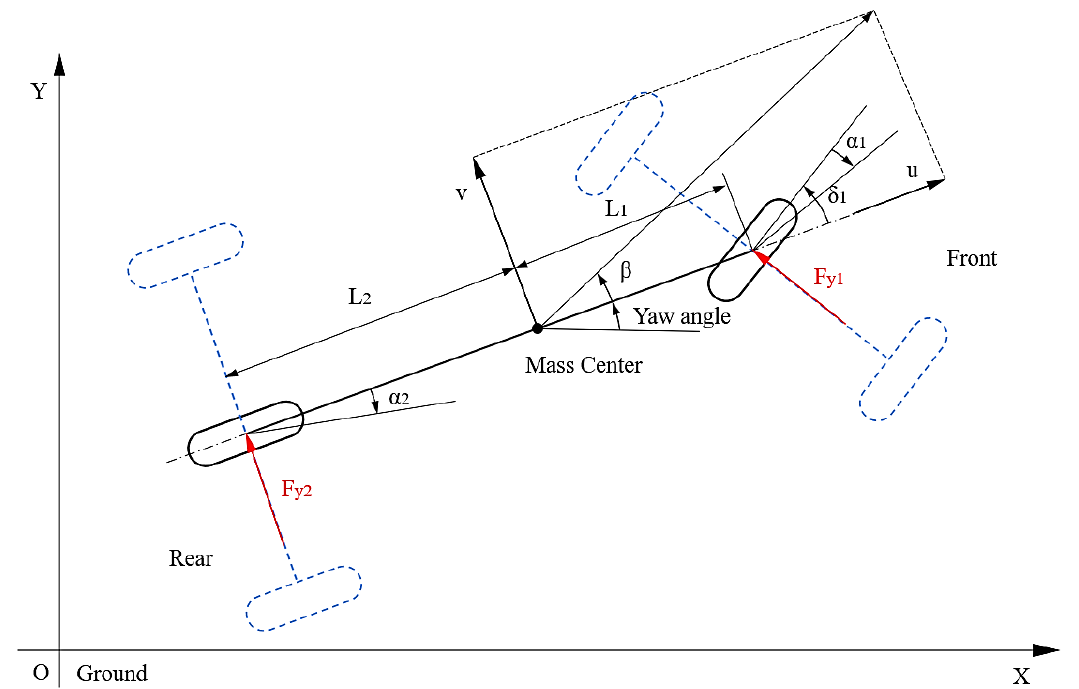
Figure 1. Monorail model with two degrees of freedom. The two wheels on the axle indicated by the blue dotted line are replaced by a monorail equivalent to the black solid line in this model.